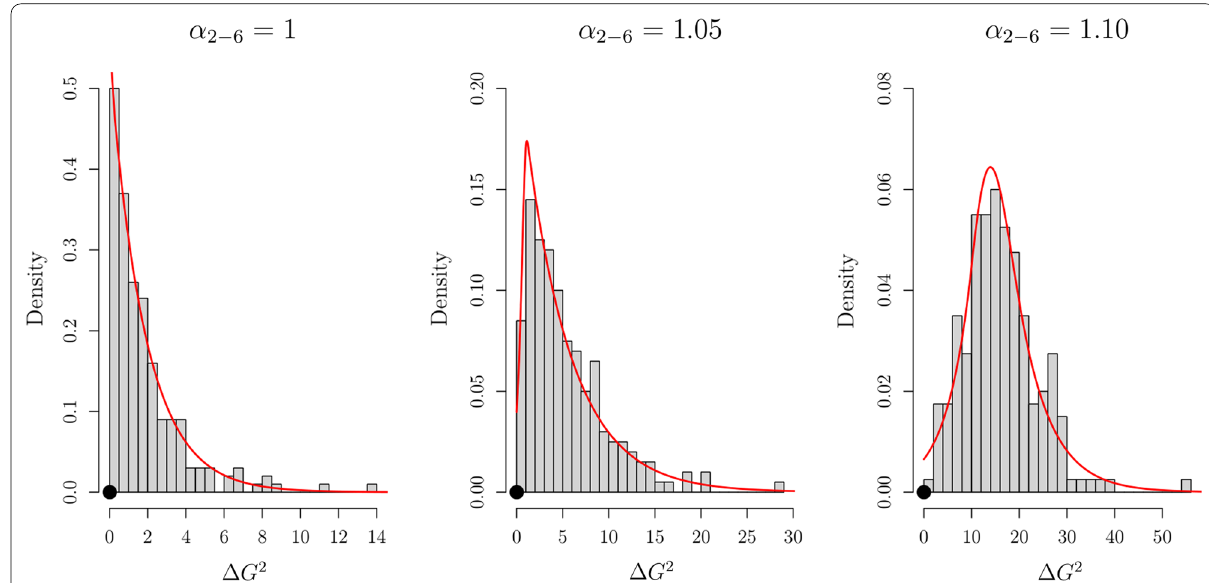
Fig. 10 Distribution of (cid:31) G 2 values, obtained from the comparison of the SDT τ 4, ∅ and SDT τ 4, µ 1 models, when generating the confidence rating data from the latter under different values of α 2 − 6 . Two-hundred datasets were generated per scenario. The black circle corresponds to the (cid:31) G 2 = 0.01 observed with the real data (see Table 3). The red lines correspond to polynomial spline approximations of the (cid:31) G 2 distributions. Please note that the ranges of both axes vary across